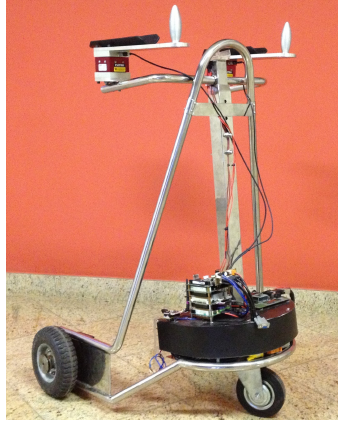
Figure 1. UFES’s smart